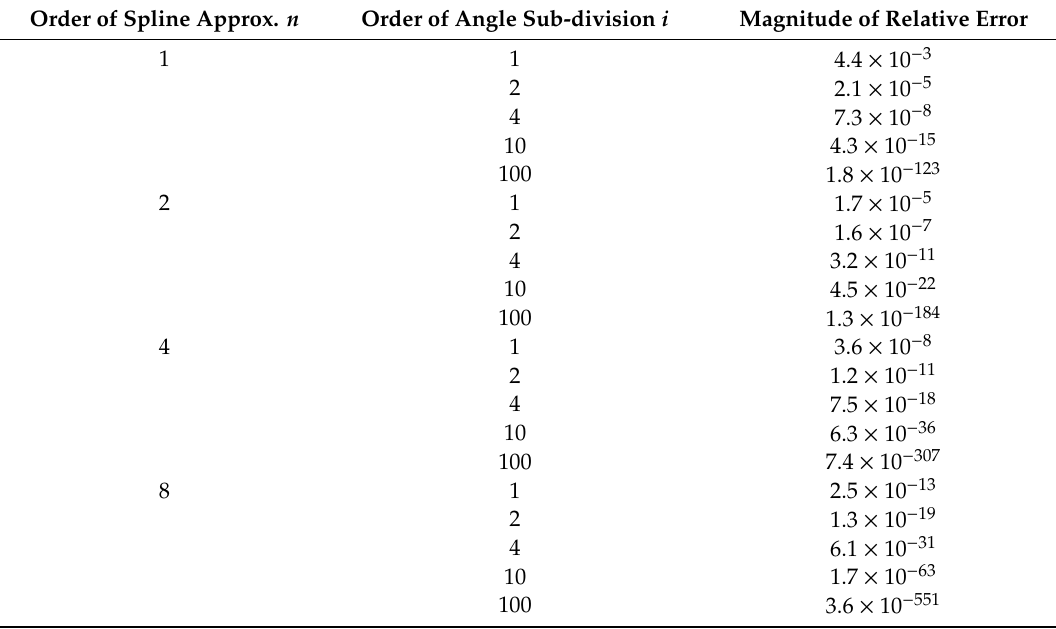
Table 8. Relative error in approximation of π based on an approximation to atan(1). Order of Spline Approx.